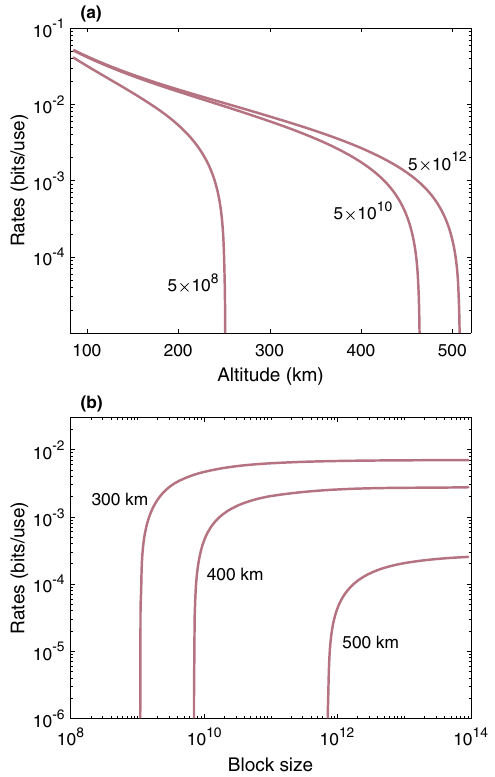
Fig. 6 Performance of satellite quantum communications at large zenith angles. In ( a ), we have fi nite-size key rates versus altitude (for fi xed values of block size). In ( b ), we have similar rates versus block-size (for fi xed values of altitude). Both fi gures consider a mask angle θ m = 4 π /9 at night- time, and windspeed v = 21 m/s and A = 1.7 × 10 − 14 m − 2/3 used in Eq. (29). Here we have set w 0 = 20 cm, a R = 70 cm, (cid:2) n B ¼ 4 : 75 ´ 10 (cid:3) 10 , (cid:2) n ¼ 0 : 001, and η = 0.63. Other parameters chosen as given in Fig. 5. cd ex Protocol parameters are taken as follows: μ = 10, β = 0.98, r pe = 0.1, d = 2 5 , frame error rate ( FER ) is 0.1, ε s = ε h = ε cor = 10 − 10 , w = 6.34, and ε = 4.5 × 10 − 10